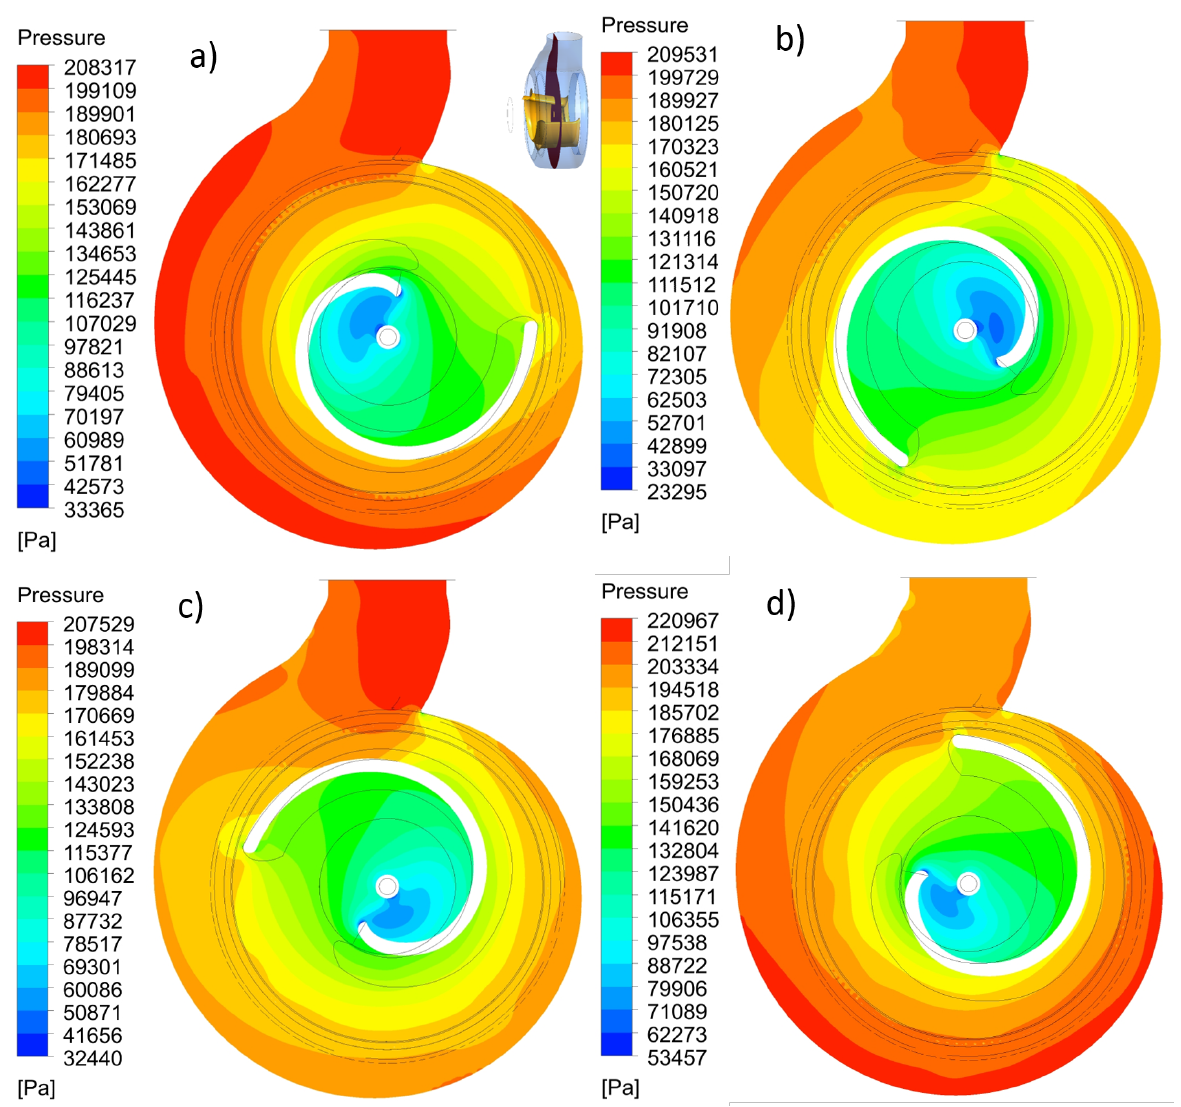
Figure 6: Pressure distribution in the middle cross-section of the pump, the position of the impeller: a) 350 ∘ ; b) 470 ∘ ; c) 550 ∘ ; d) 620 ∘